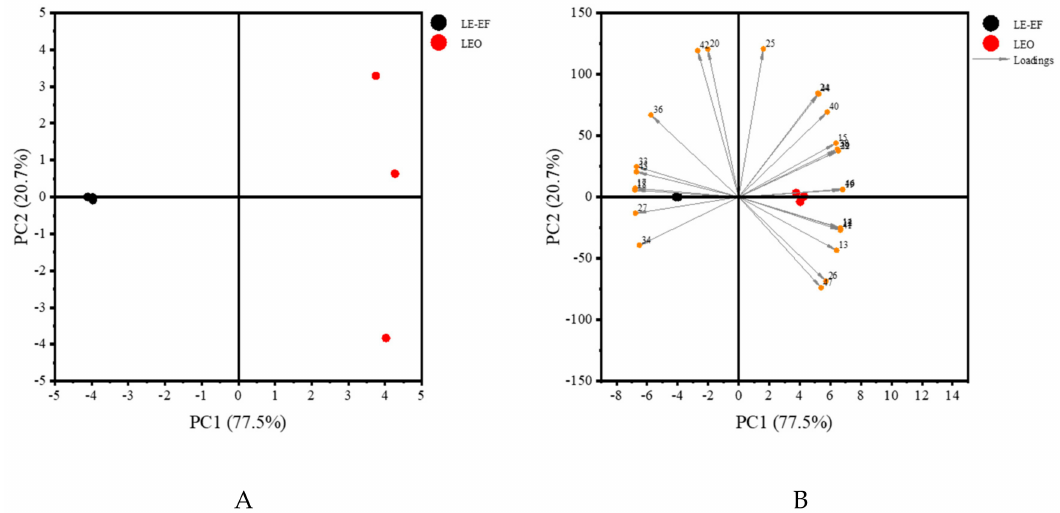
Figure 3. Principal component analysis (PCA) of lavender extracts and lavender essential oil. ( A ) The score plot of PCA analysis. ( B ) The biplot of PCA analysis. Compound numbers correspond to Table